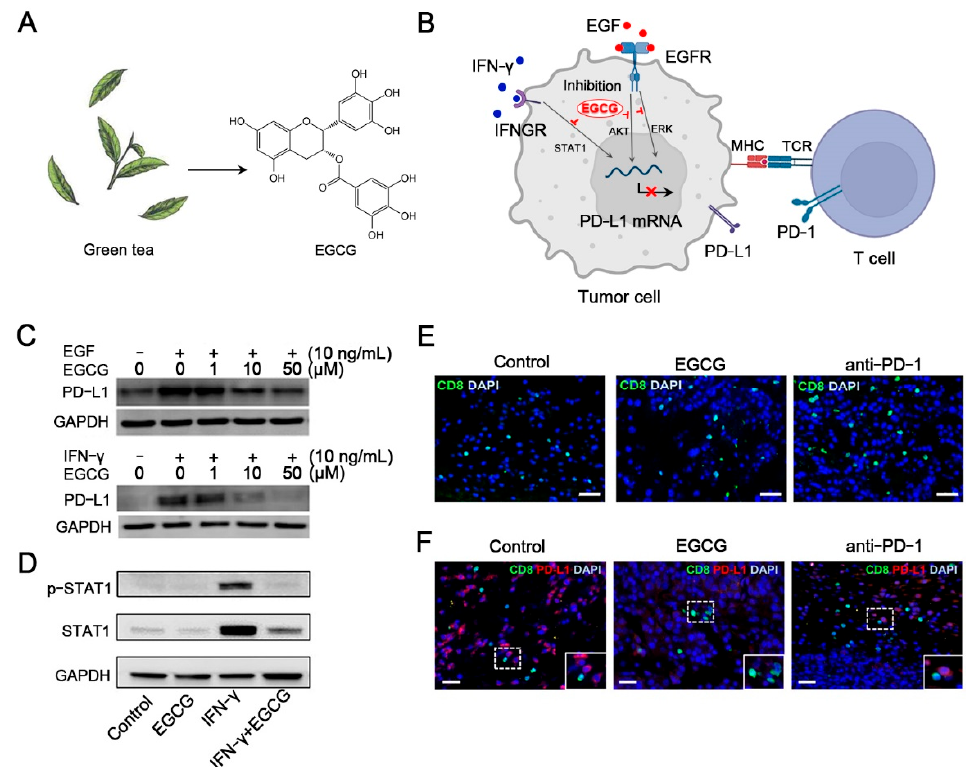
Figure 3. Schematic of EGCG for cancer immunotherapy. ( A ) EGCG is the active compound derived from green tea. ( B ) Schematic of the mechanisms of EGCG for the inhibition of the PD-1/PD-L1 axis. ( C ) Downregulation of epidermal growth factor (EGF) and IFN- γ -induced PD-L1 protein in Lu99 cells after EGCG treatment. ( D ) Downregulation of p-STAT1 and STAT1 in B16F10 cells after EGCG treatment. ( E ) Immunofluorescence images of tumor tissue sections stained with CD8 (green) and DAPI (blue). ( F ) Immunofluorescence images of tumor tissue sections stained with CD8 (green), PD-L1 (red), and DAPI (blue). Reprinted with permission from Ref. [90]. Copyright 2018, copyright MDPI. Reprinted with permission from ref. [91]. Copyright 2021, copyright MDPI.